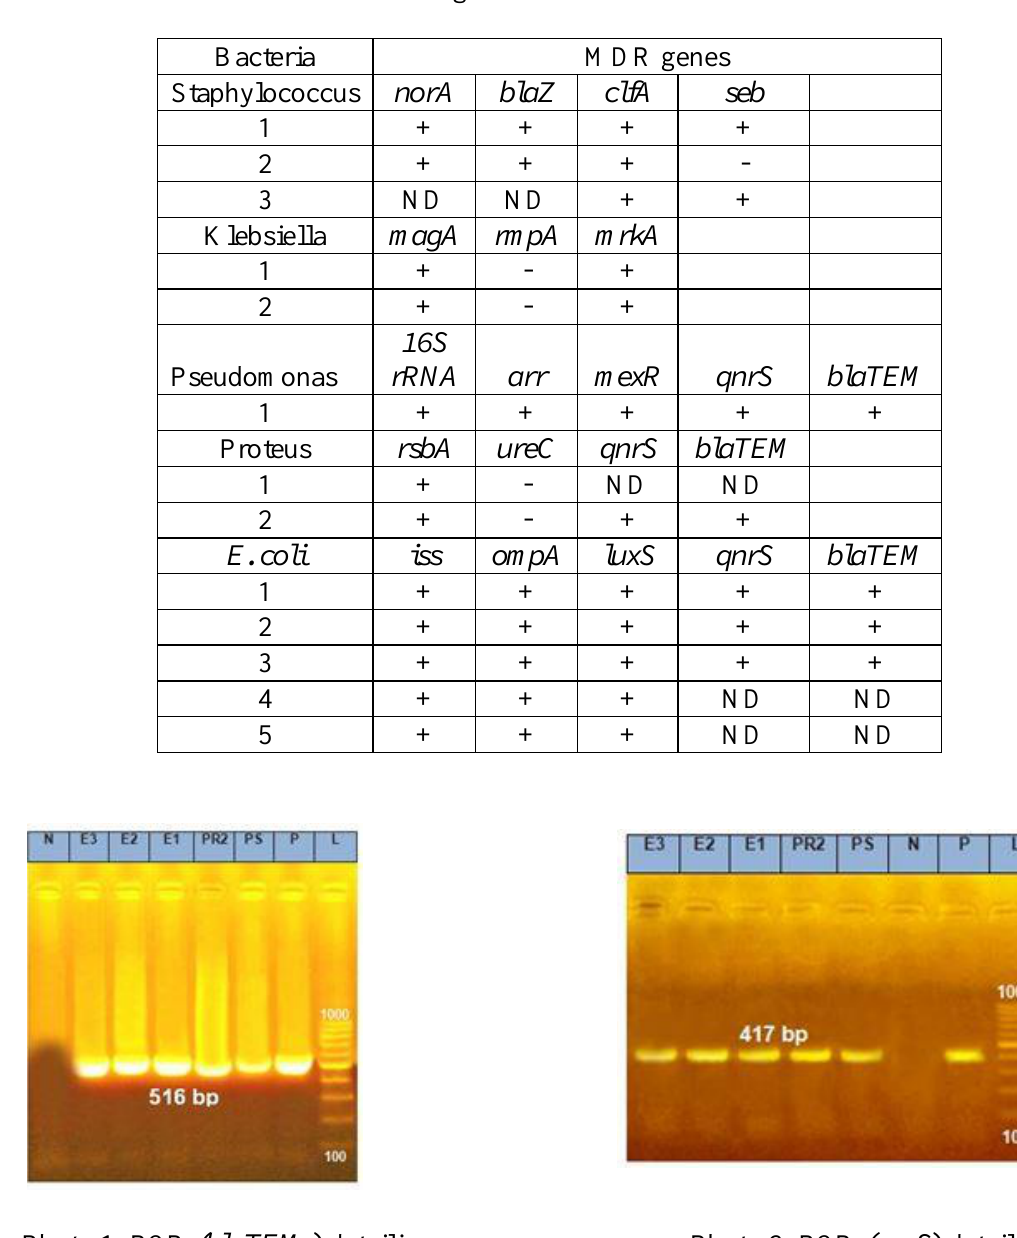
Table 5: PCR of MDR and virulence genes in different bacterial isolates from cat and dog